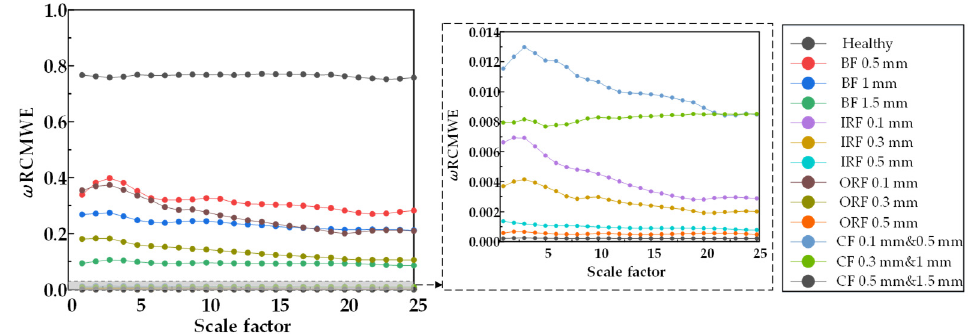
Figure 32. ω RCMWE entropy values of 25 scale factors under different damage degrees.